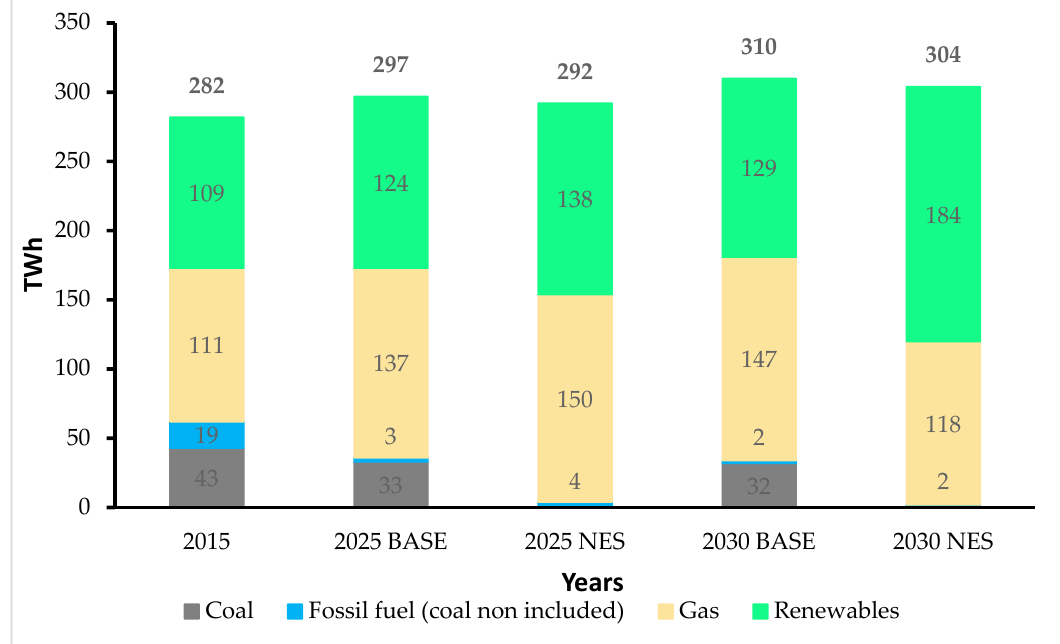
Figure 4. Evolution of Italian energy generation mix in the baseline scenario (based on pre-2014 policies) and the National Energy Strategy (NES)/ National Energy and Climate Plan (NECP) scenario (TWh) [18].